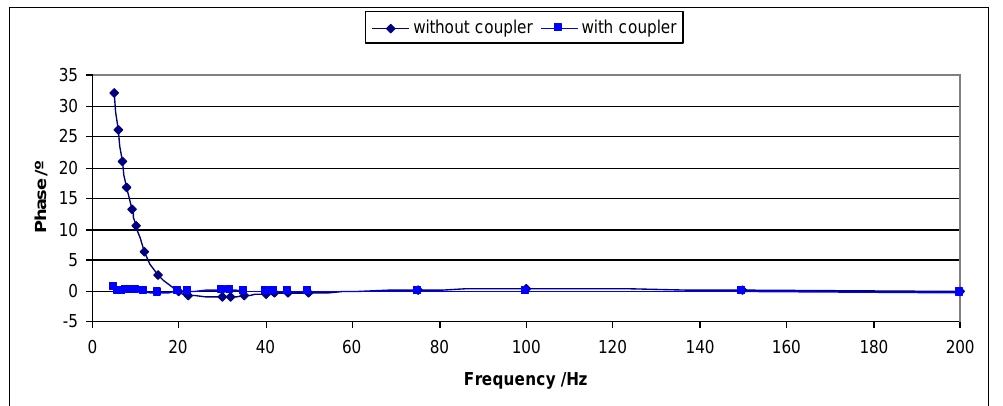
Figure 10. The figure represents the phase versus the excitation frequency for the Interface 1610 sensor. One curve is for the case without the coupler and the other case is for the case when the coupler is